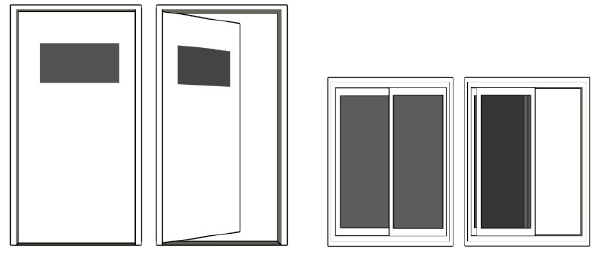
Figure 5. Different states of a door or window.